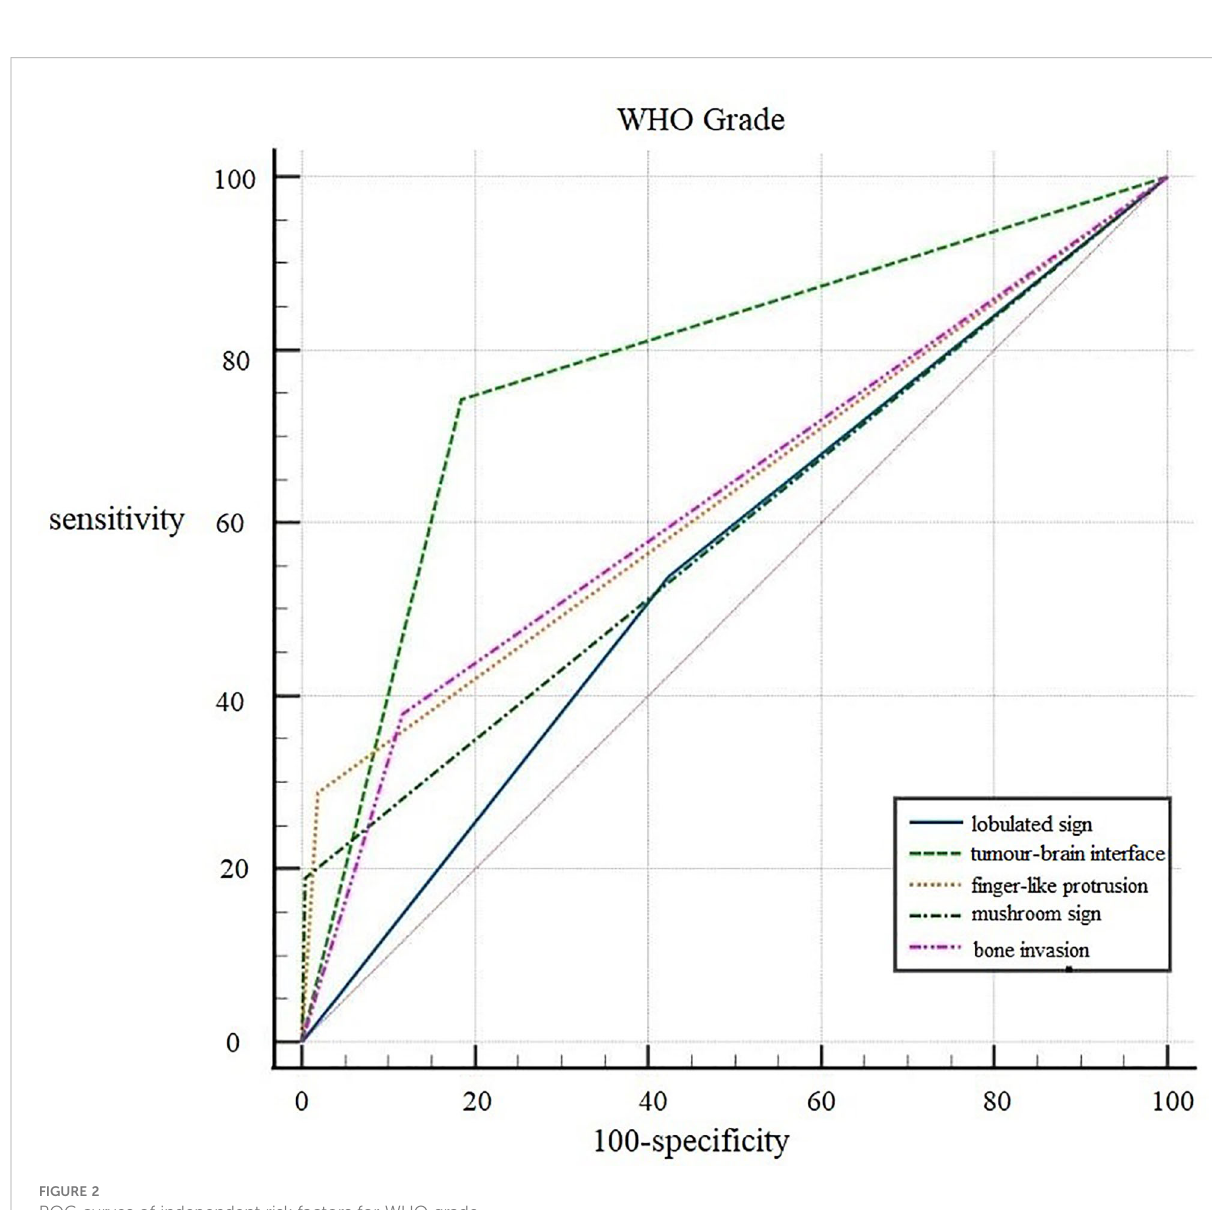
FIGURE 2 ROC curves of independent risk factors for WHO